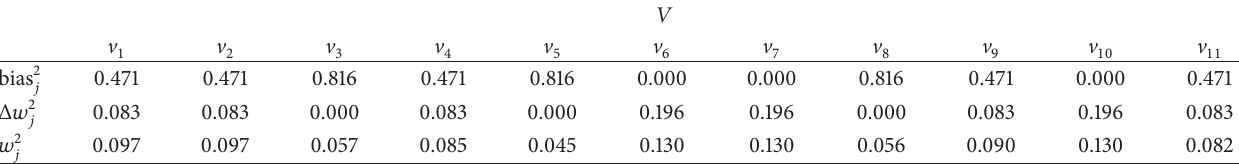
Table 2: Weights correction results of the second stage voting.